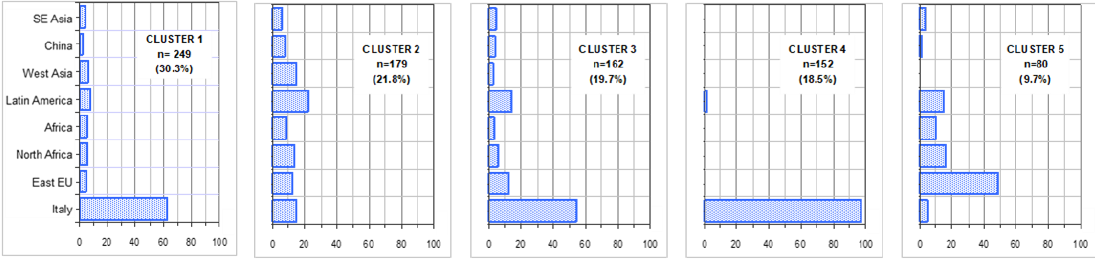
Figure 5. Ethnic composition of each cluster.